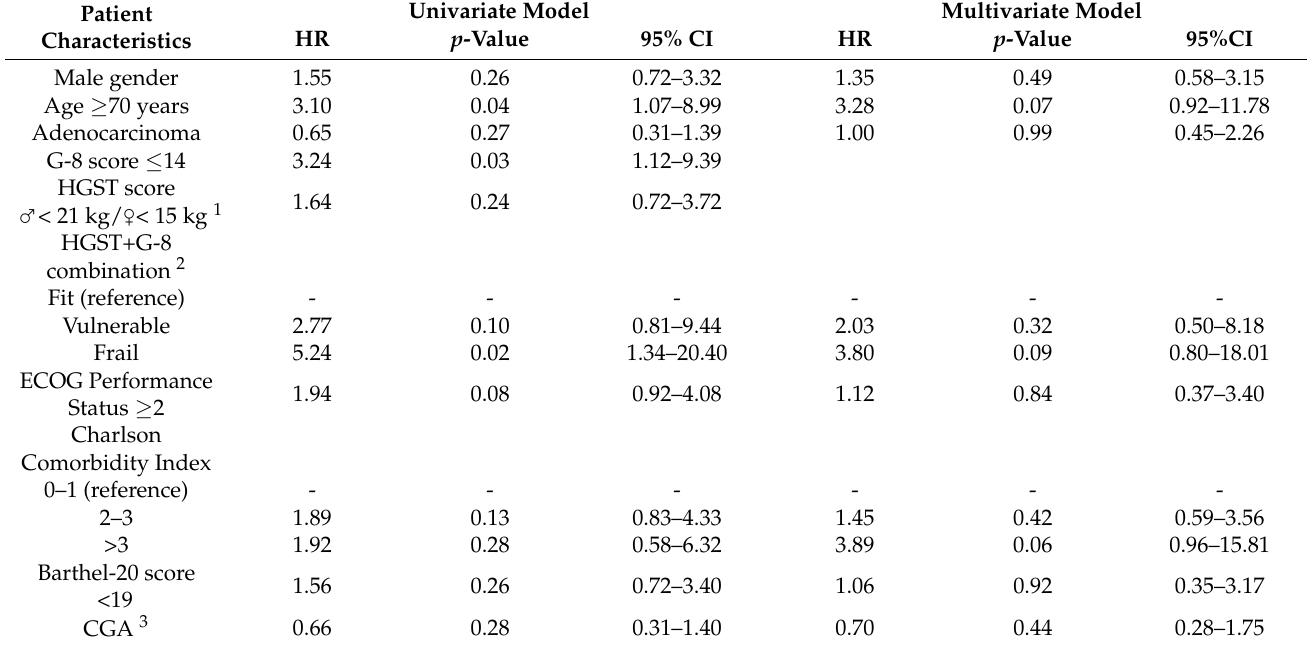
Table 2. Univariate analysis and Cox multivariate regression model in patients with localized non-small cell lung cancer who were treated with stereotactic body radiation